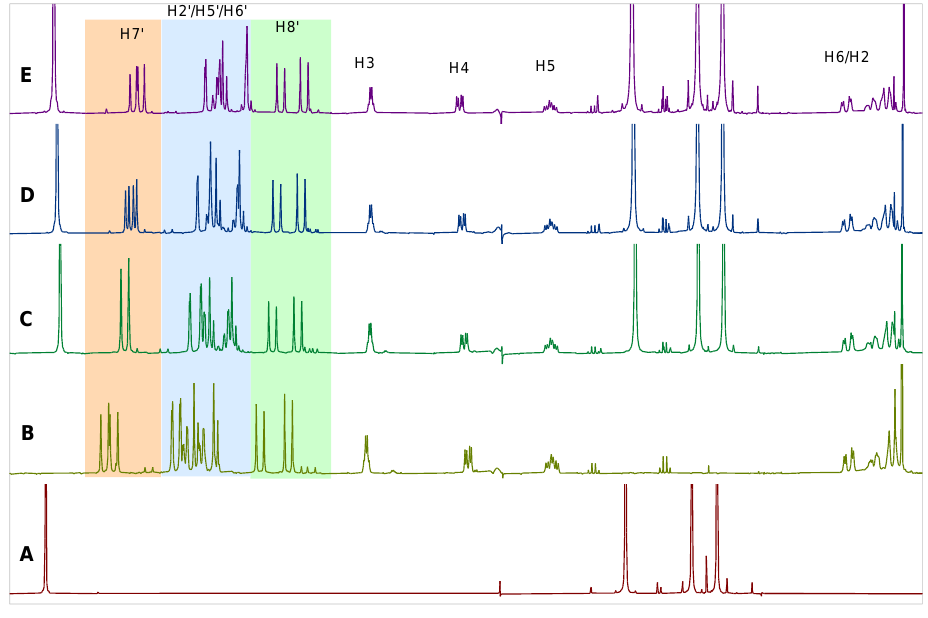
Figure 5. Effect of sequential caffeine addition to the 1 H NMR chemical shifts of 3,4-diCQA (3.4 mM) and caffeine showing ( A ) pure caffeine, ( B ) 0 mM caffeine addition, ( C ) 9 mM caffeine addition, ( D ) 27 mM caffeine addition, ( E ) 45 mM caffeine addition.